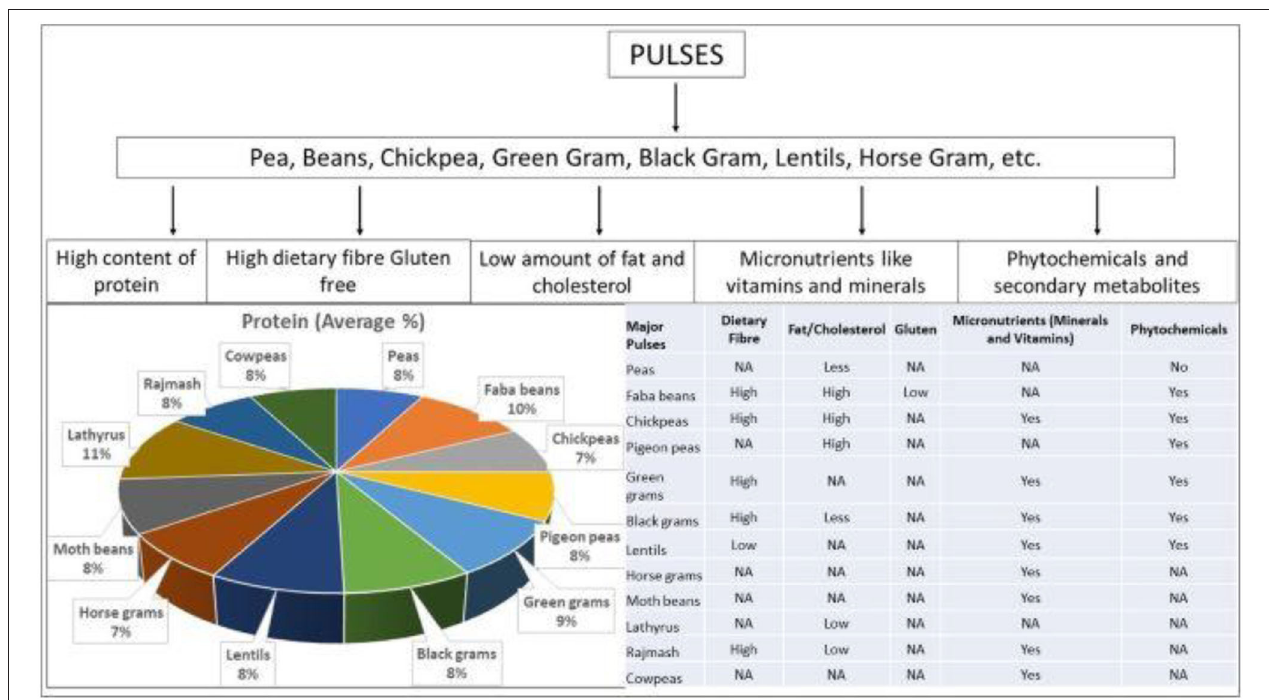
FIGURE 2 | General nutritional profile of different pulses (Source: Venkidasamy et al., 2019). NA, not